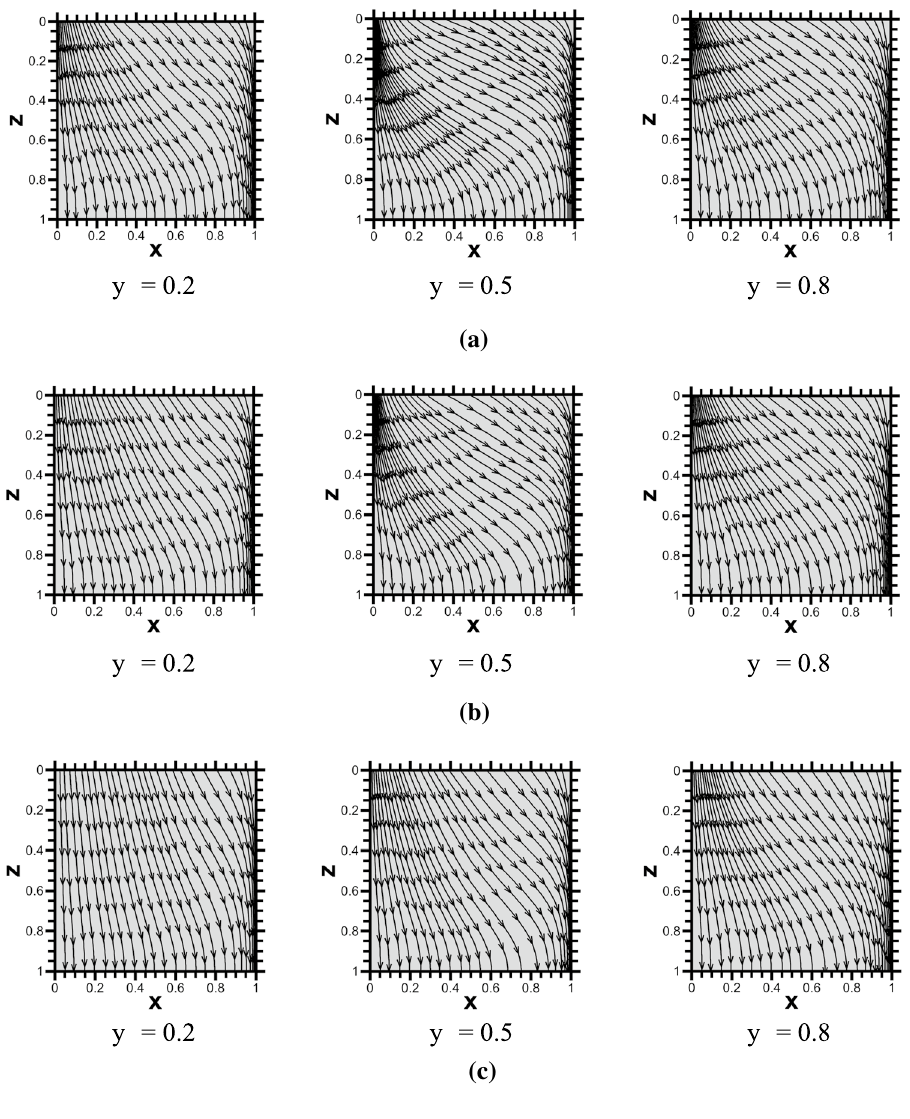
Fig. 18 A sample of the stream lines in the plan for pass- ing plates through the depth 𝜐 ( = 0.05), a t = 0.05, b t = 0.1, c t =